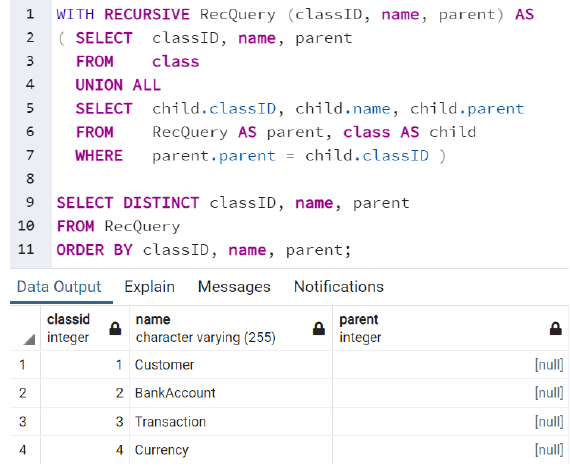
Figure A7. Query